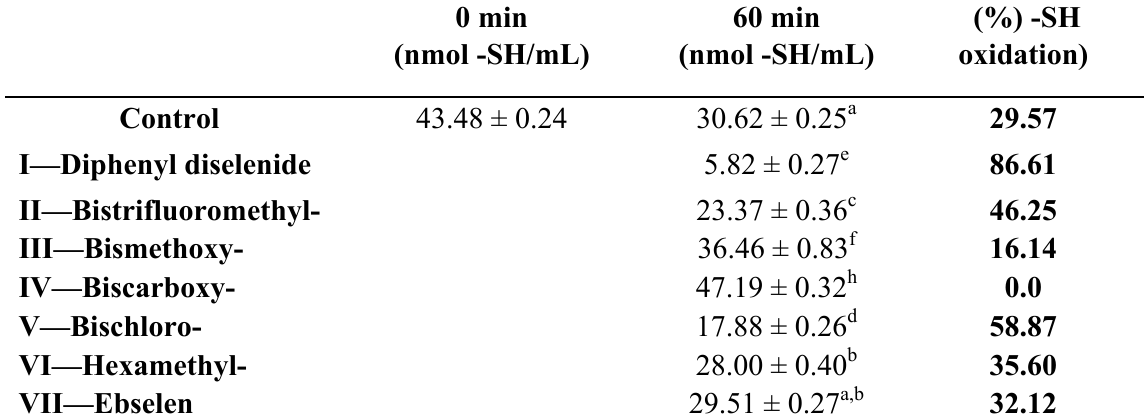
Table 1. Effects of different selenium compounds on DTT